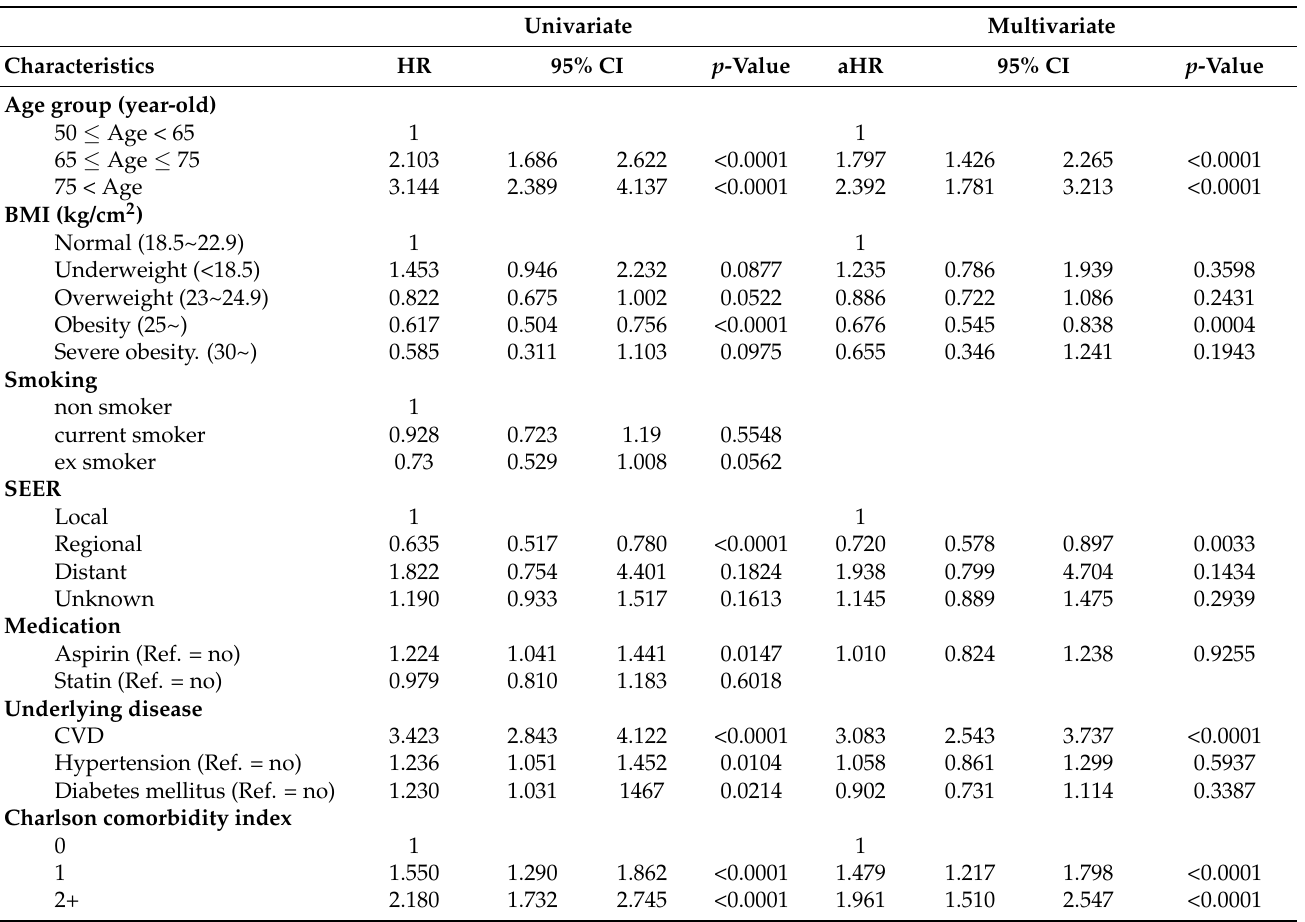
Table 2. Multivariate cox regression of risk factors for dementia among overall patients after propensity-score matching and extended survival analysis. Univariate